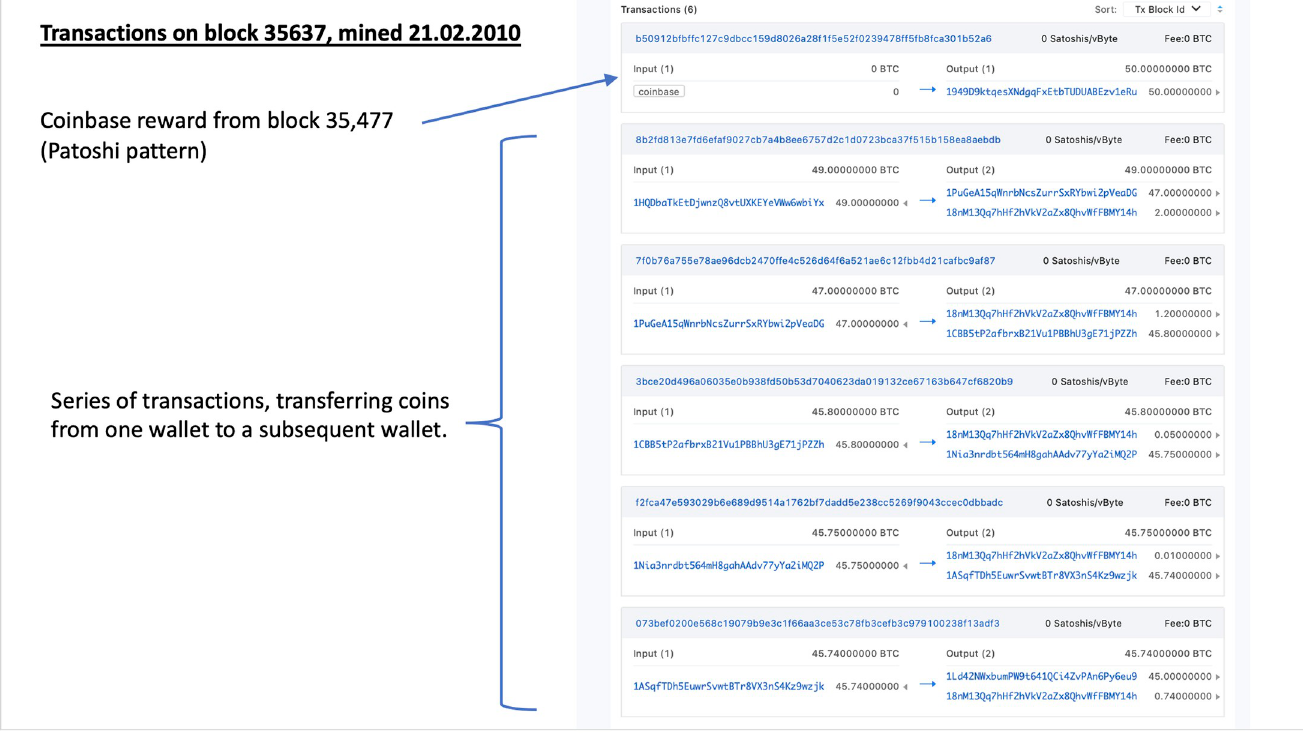
Fig 9. Transactions on block 35637, mined 21.02.2010.